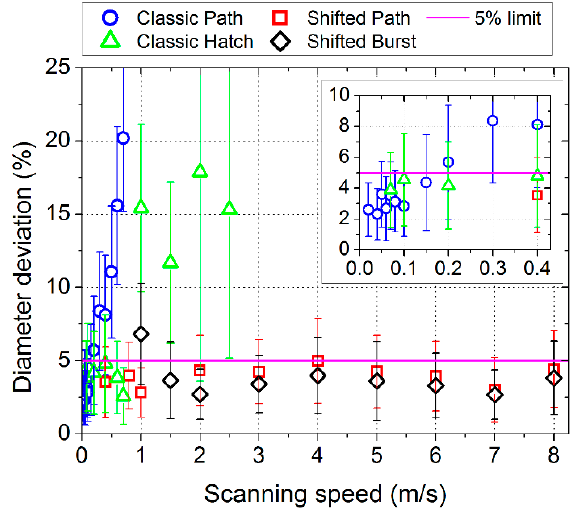
Figure 5. Measured relative deviation of the surface dimple diameter depending on the laser beam speed for different laser texturing methods (scanning strategies). speed for di ff erent laser texturing methods (scanning strategies).